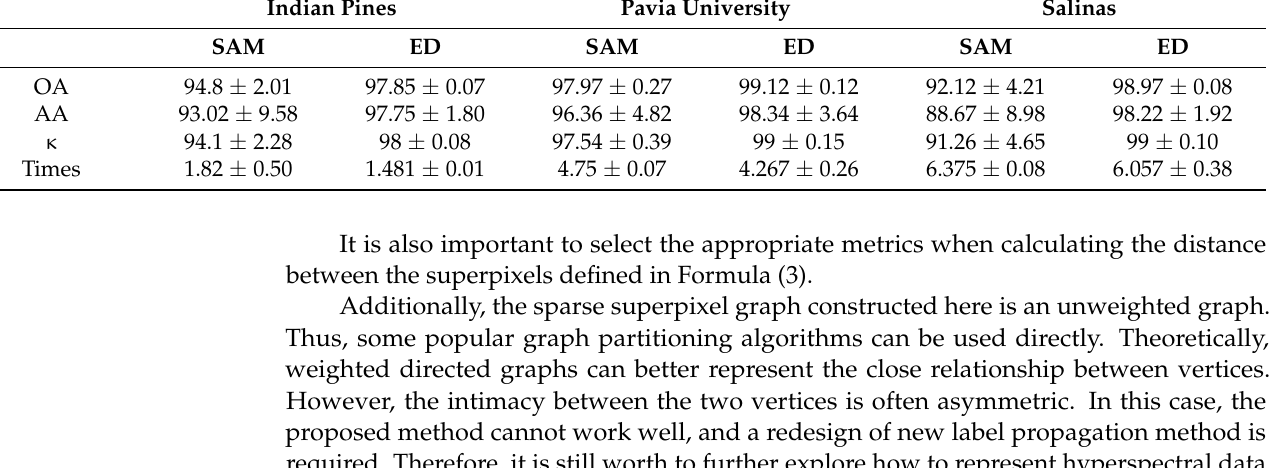
Table 6. Classification results and running time (seconds) on three images. Indian Pines Pavia University Salinas SAM ED SAM SAM